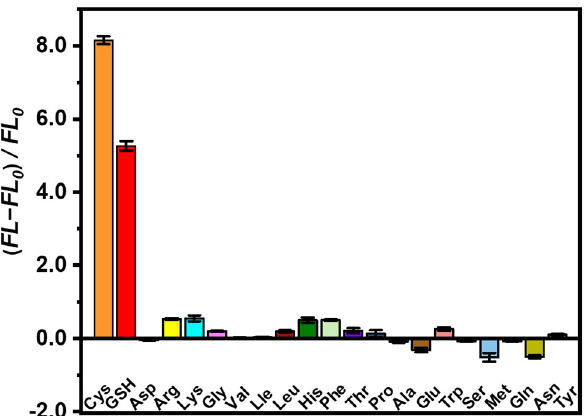
Figure 4. Fluorescence intensity change of AuNCs@ZIF-8 at λ ex = 400 nm in the presence of various amino acids.